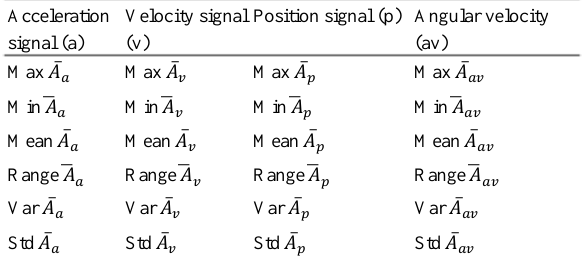
Table 2. List of extracted features and related time domain